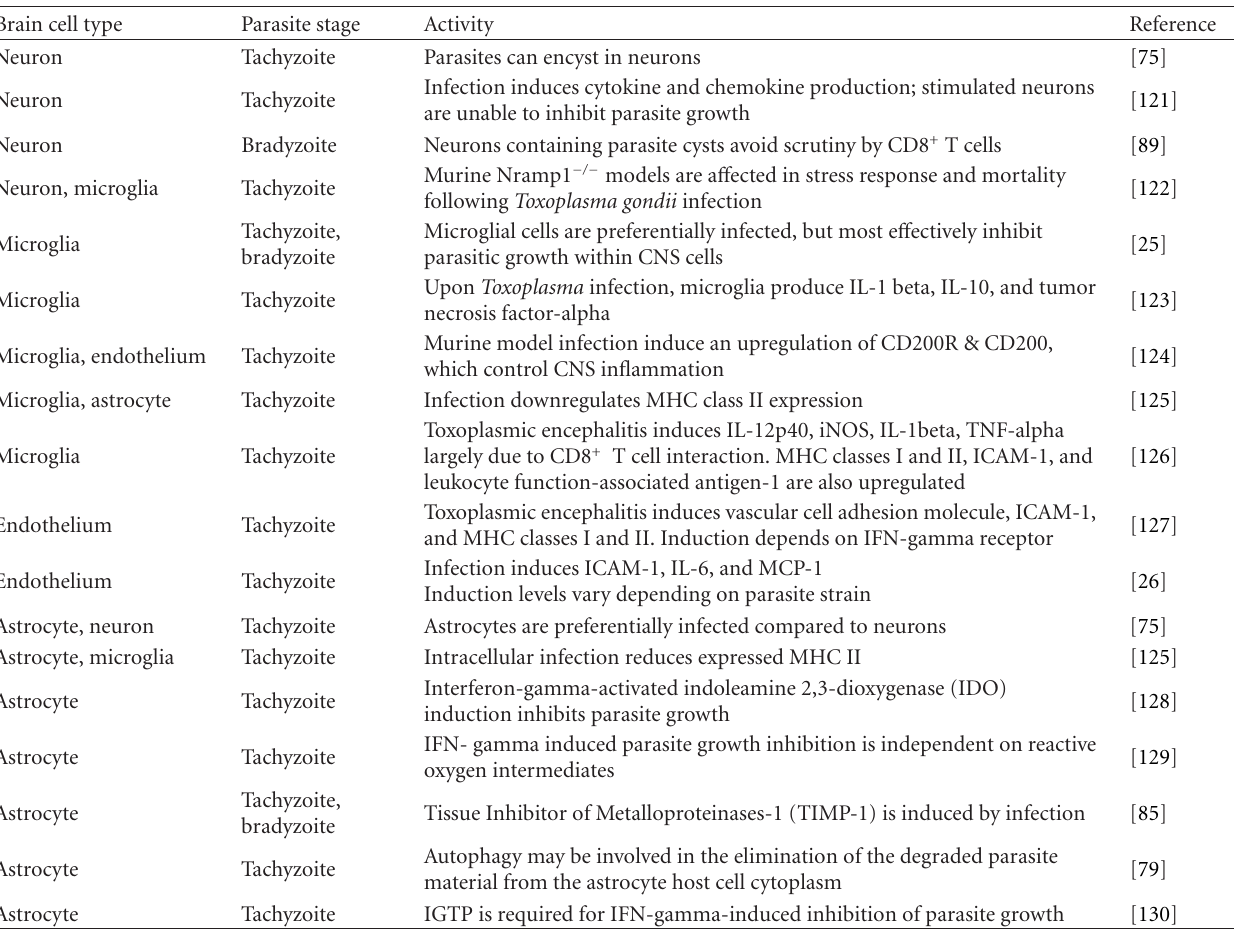
Table 1: The response of CNS-resident cells to Toxoplasma gondii